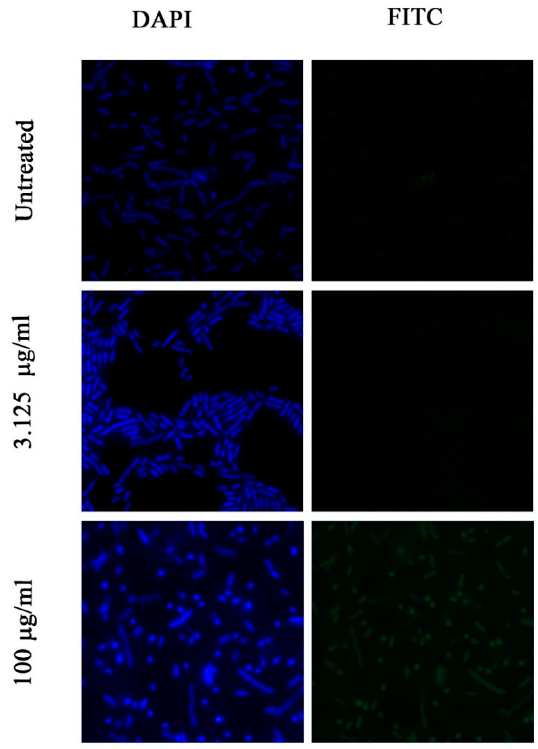
Figure 4. Images of fluorescence of DAPI a FITC before and after treatment of SP15 with concentrations of 100 µg/mL and close to MIC. Pharmaceuticals 2019 , 12 , x FOR PEER REVIEW